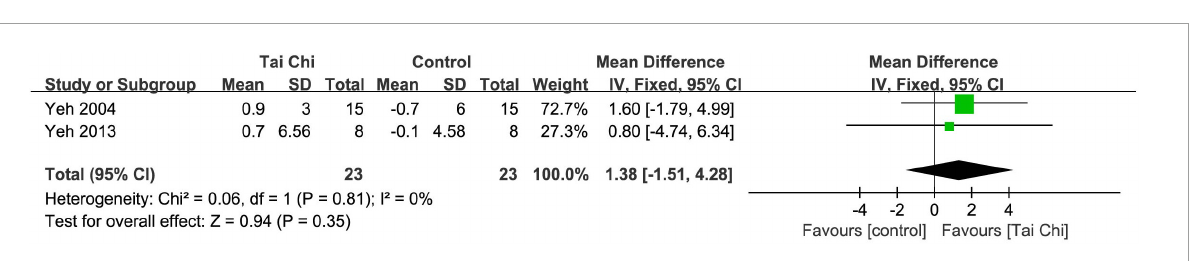
FIGURE9 Meta-analysis of peak VO2 in the Tai Chi group vs. the control group. CI, confidence interval; IV, inverse variance; SD, standard deviation.